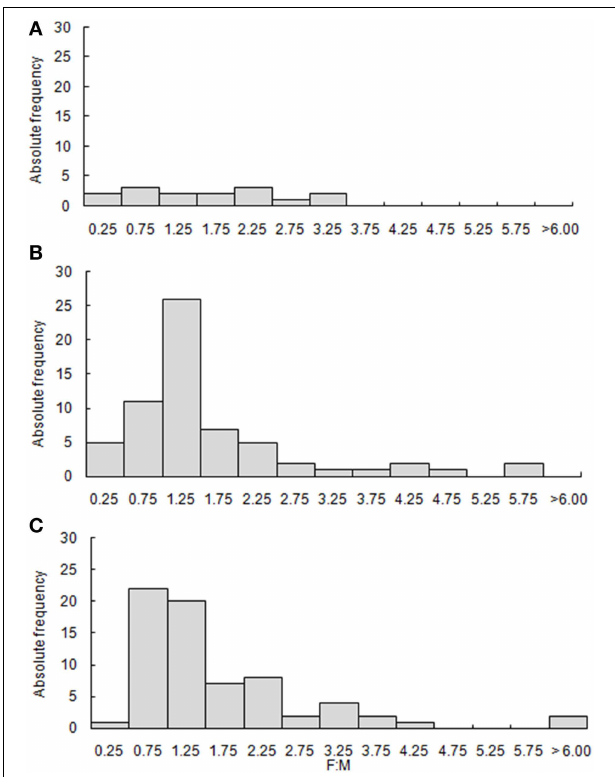
FIGURE 8 | Frequency distribution of the number of females (F) in relation to the number of males (M) sampled for the three Brazilian LMEs. (A) North Brazil Shelf; (B) East Brazil Shelf; and (C) South Brazil